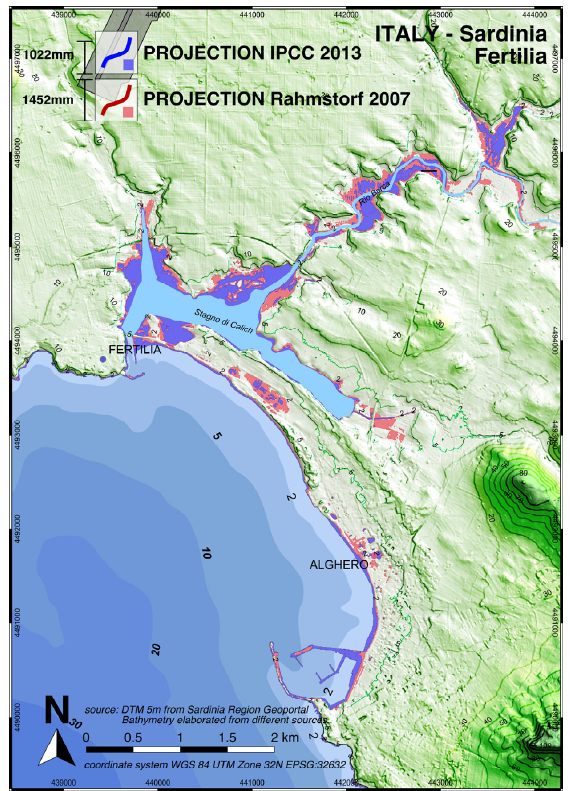
Figure 2. Map 1 Fertilia (Sardinia Italy, see also Figure 1 for location). The potential submersion area,